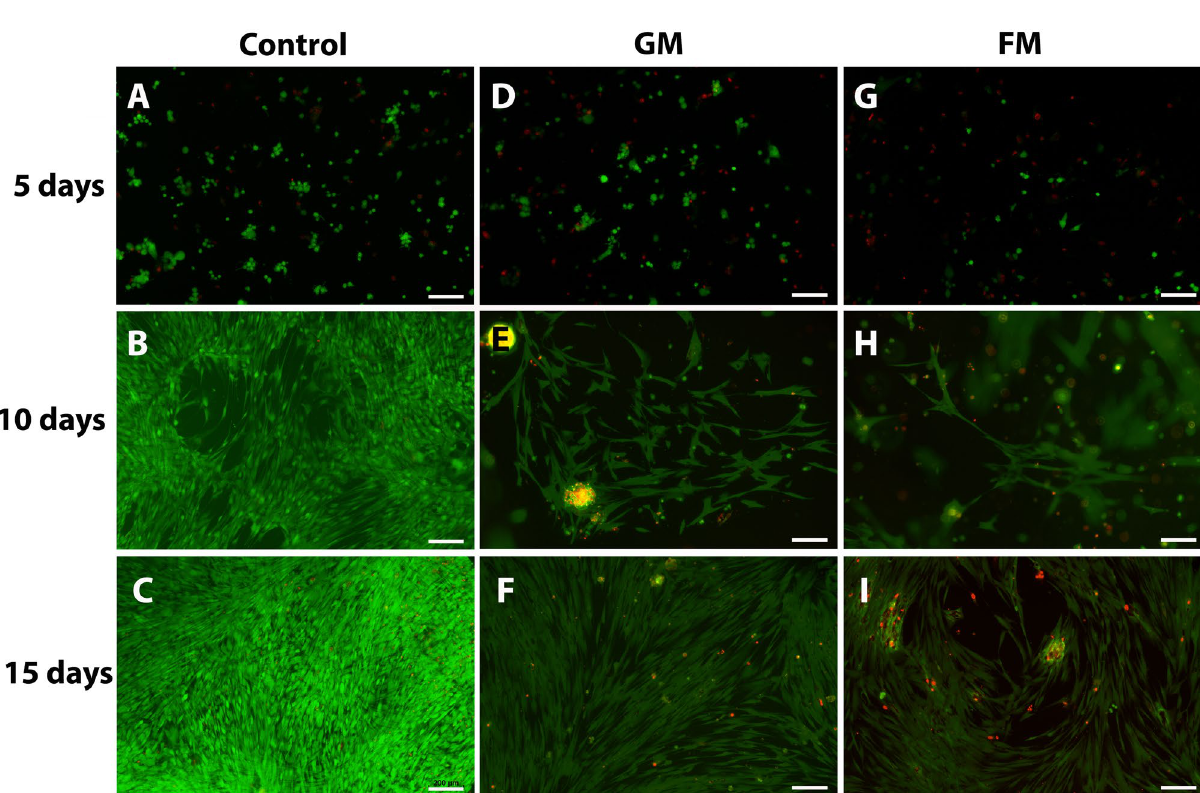
Figure 2. Live/Dead assay of hDPSCs in gelatin-based and fibrin-based scaffolds. DPSCs were cultured with gelatin-based ( D – F ) and fibrin-based matrices ( G – I ) in three-dimensional conditions and without scaffolds in two-dimensional conditions as controls ( A – C ). Green fluorescence indicates cytoplasm of live cells, while red fluorescence indicates nuclei of dead cells. Scale bar: 200